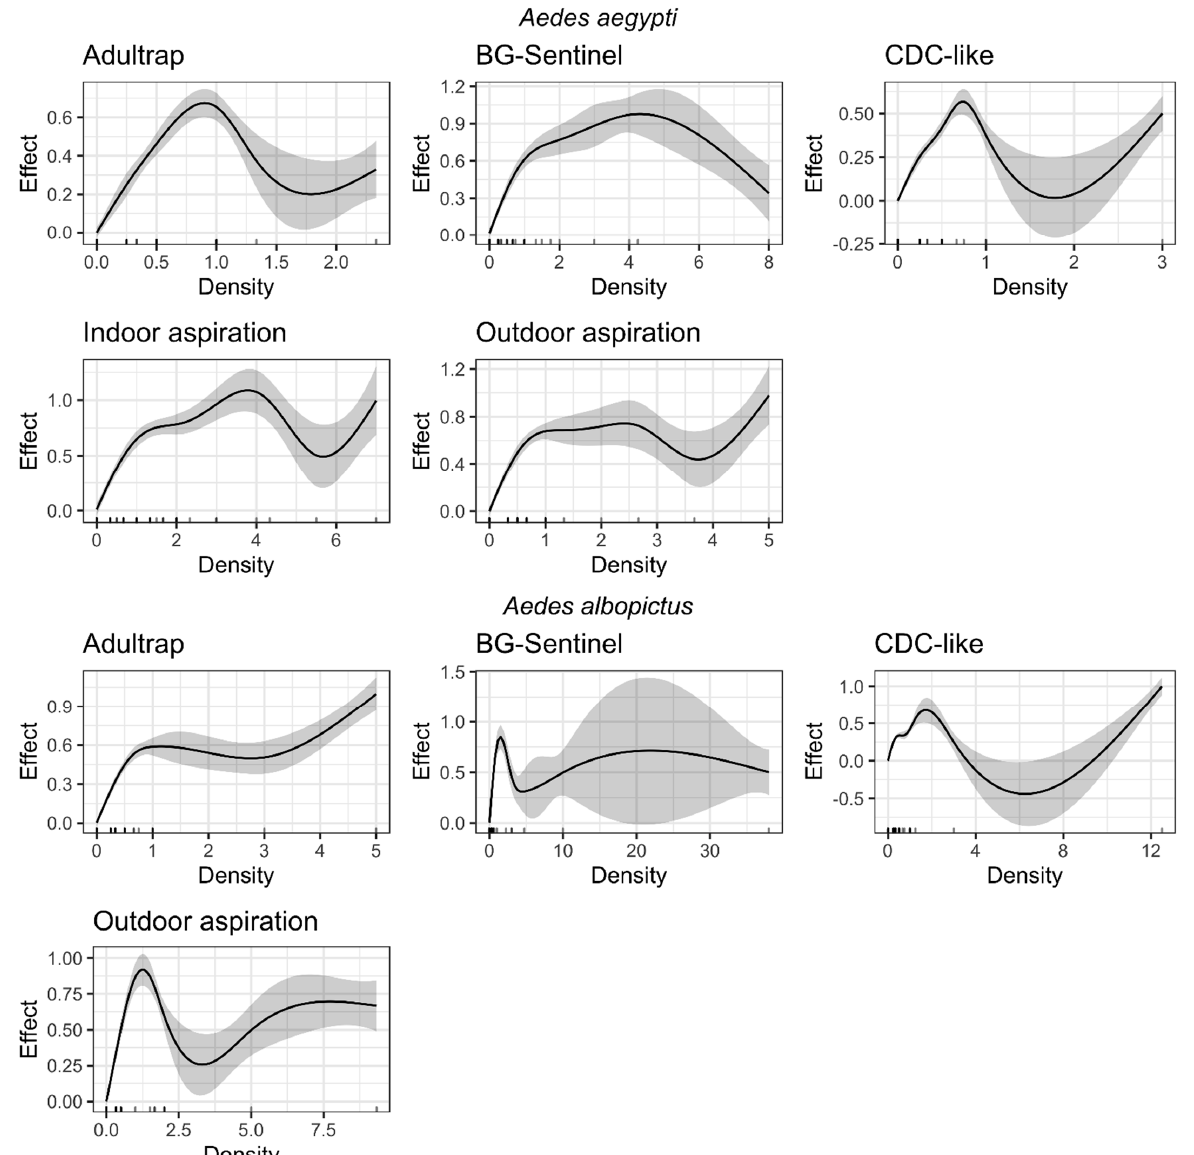
Figure 4. Estimated smoothing curves for Ae. aegypti (top) and Ae. albopictus (bottom). The solid line represents the smoother function; the grey area represent 95% confidence intervals. ADT = Adultrap, BGS = BG-Sentinel, CDC = CDC light trap, ASP-I = Indoor aspiration, ASP-O = Outdoor aspiration. Dotted red lines are placed at zero to facilitate visual interpretation. It was impossible to fit an ASP-I model for Ae. albopictus because of the low number of observations. x-axis represent the density indexes for each trap and each species; y-axis represent the effect of the density index on the positivity index for each trap and each species.